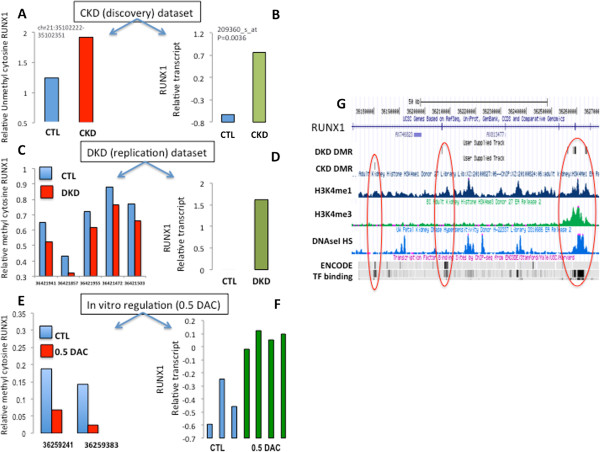
Gene body cytosine methylation changes drive gene expression differences. RUNX1 methylation and gene expression were examined only (A,B) In the original discovery dataset, the gene body region of RUNX1 was hypomethylated (A) and the corresponding transcript level was increased (B) in the CKD (discovery) dataset. CTL, control. (C,D) The differential methylation (C) and expression (D) of RUNX1 in the DKD replication dataset. (E,F) Transcript levels are increased (F) in vitro in cultured tubules after decreasing the methylation level of the locus following 0.5 μM decitabine (DAC) treatment (E). (G) Genomic representation of the RUNX1 locus showing DMRs in the DKD dataset and in the CKD dataset. Different tracks are shown for the RUNX1 locus, including RefSeq gene, DMRs in the DKD dataset, DMRs in the CKD cells, and histone ChIP-seq data for H3K4me1 and H3K4me3 for adult kidney cortex and DHS sites from fetal kidneys. In addition, ENCODE-based transcription factor binding sites are also shown.